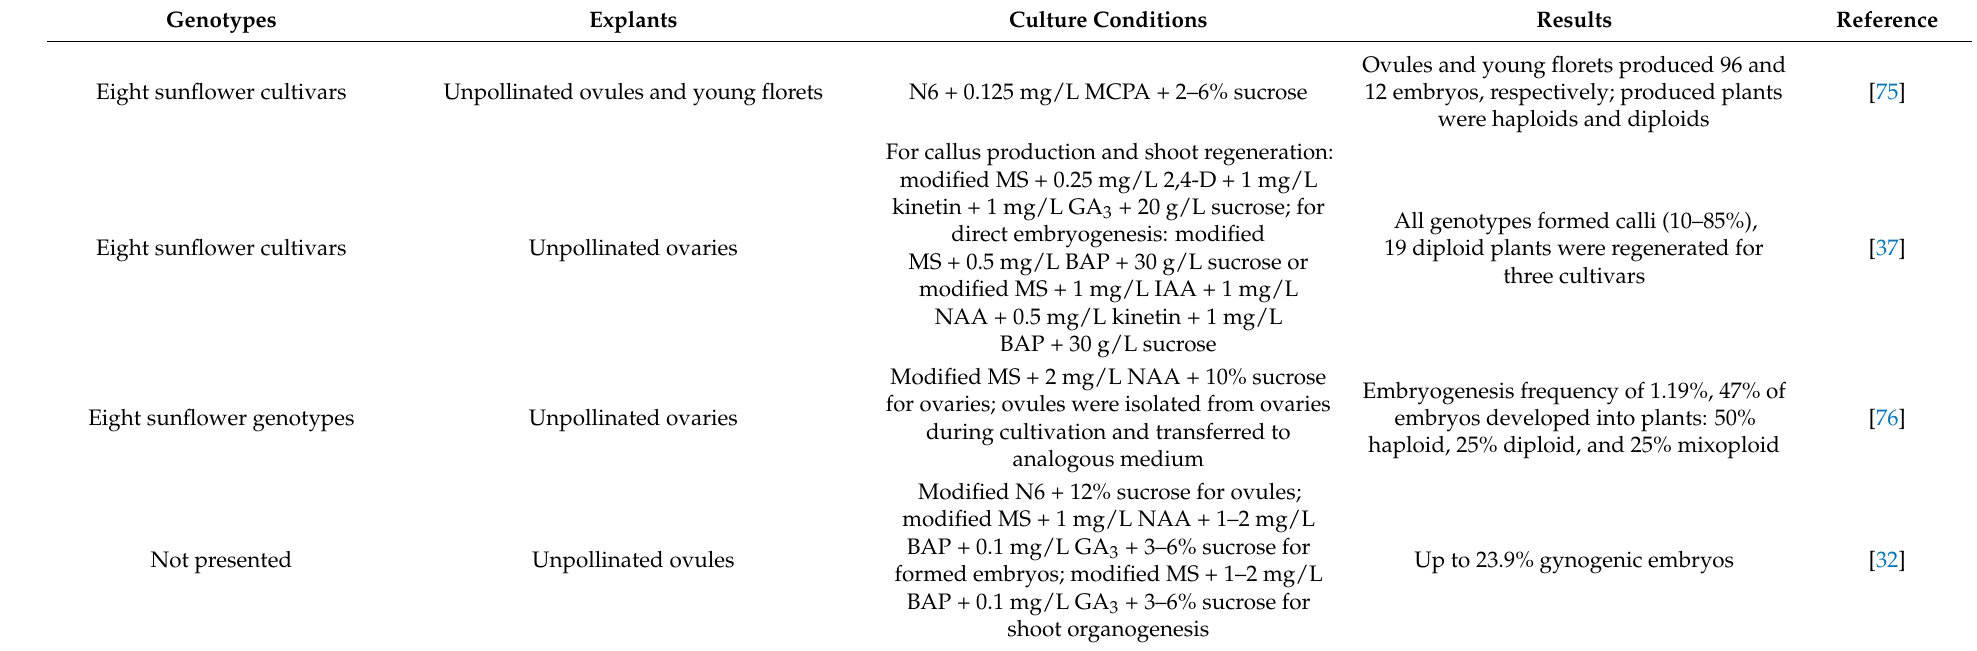
Table 3. Brief characterization of protocols for producing gynogenic sunflower